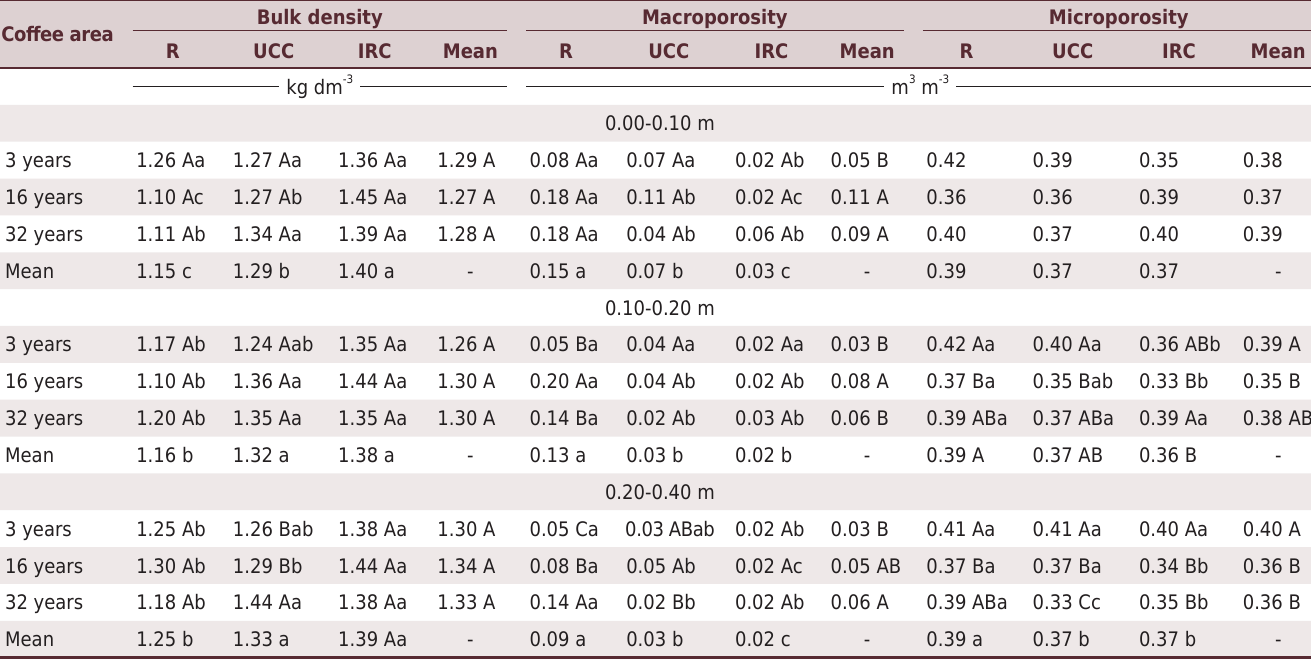
Table 3. Soil bulk density, macroporosity, and microporosity of an Ultisol, in areas cultivated with coffee, with different deployment times (3, 16, and 32 years), at 0.00-0.10, 0.10-0.20, and 0.20-0.40 m layers, and different sampling sites Bulk density Coffee area